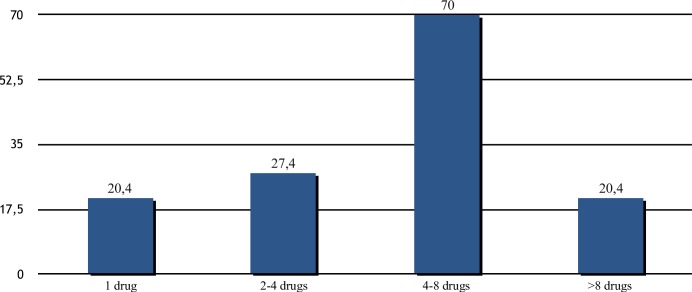
SVR12 overall and by baseline characteristics.SVR12 were extremely high regardless of baseline characteristics of patients including fibrosis stages, HCV genotypes and key populations including PWID.